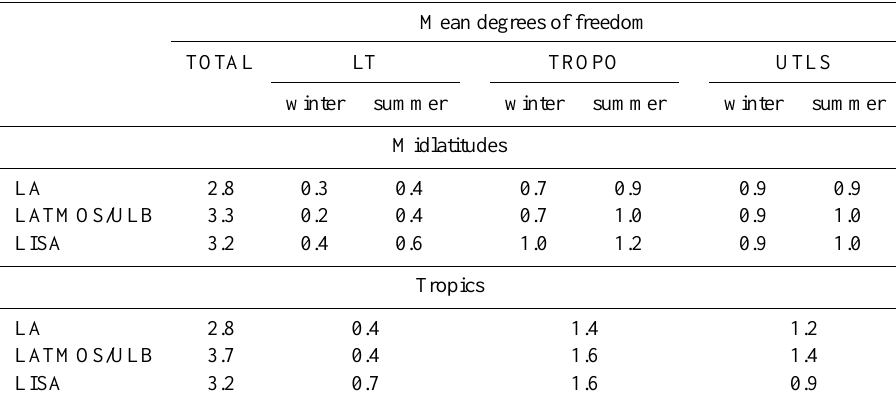
Table 4. Degrees of Freedom (DOF) for different partial columns of ozone averaged over the sets of pixels in coincidence with the ozoneson- des defined for each group (LA, LATMOS/ULB, LISA). The mean DOF are given in the midlatitudes and in the tropics separately as well as for winter and summer of the northern midlatitudes.